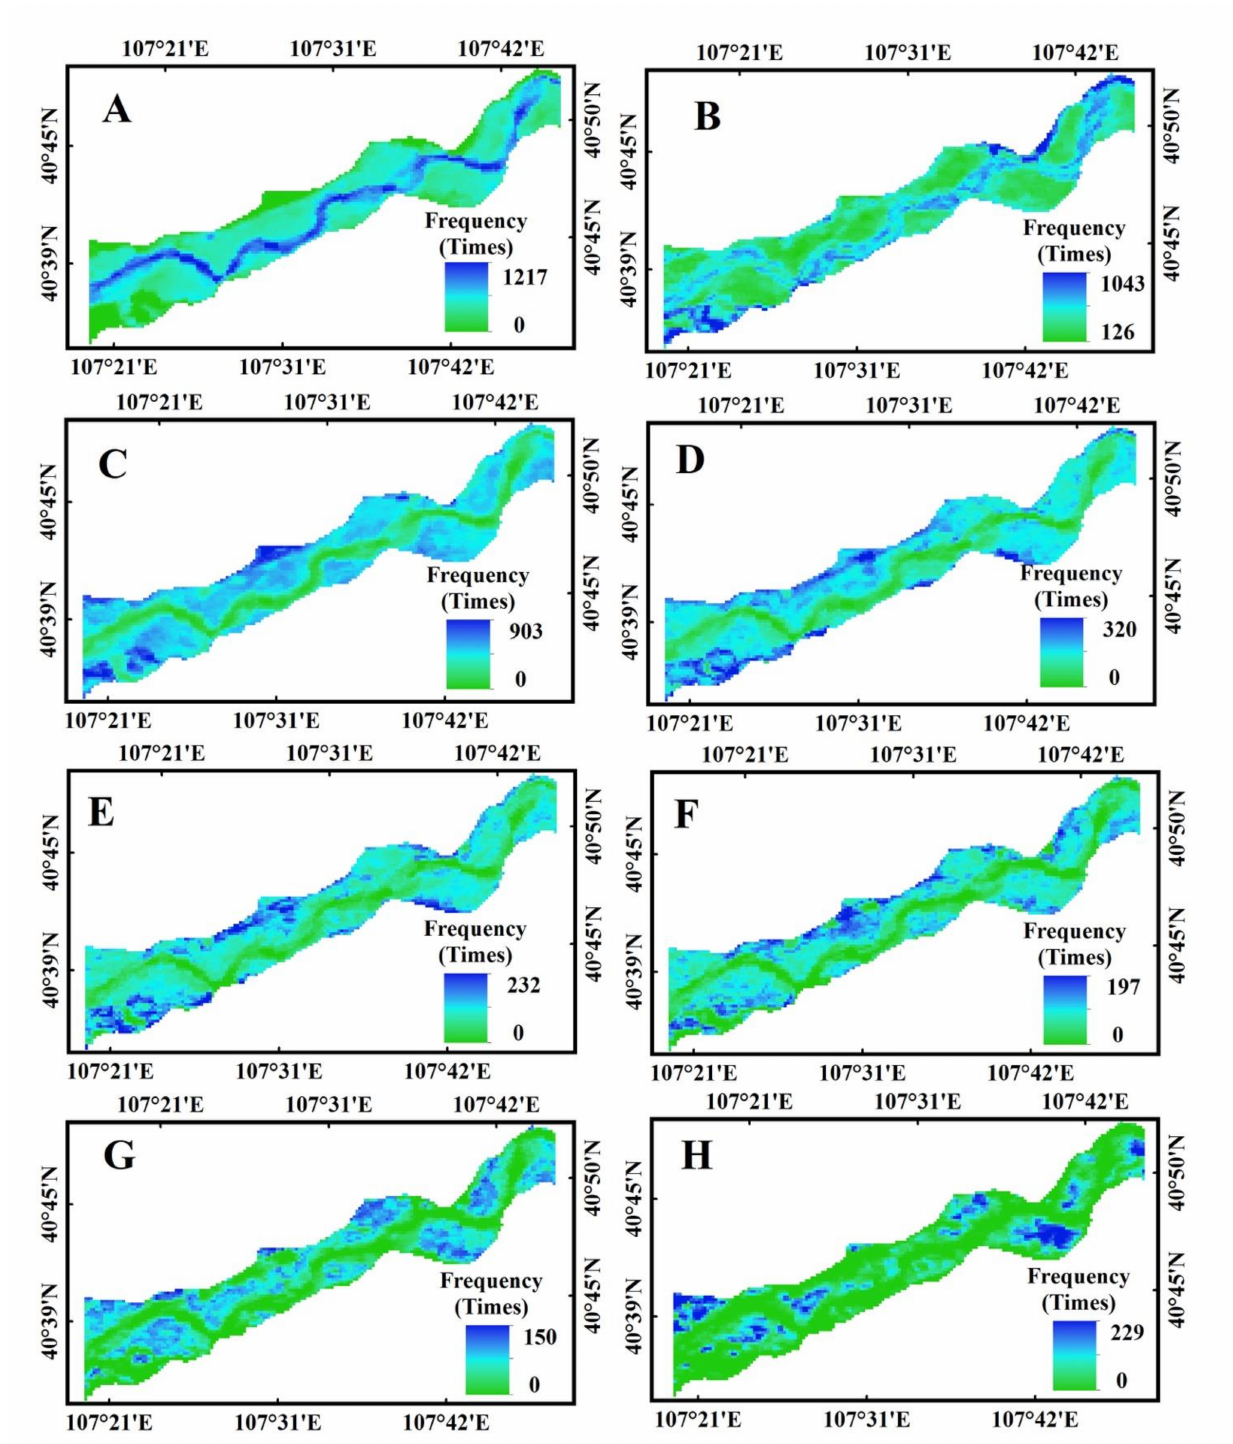
Figure 9. Pixel based spatial distributions patterns of the NDVI frequency. ( A ) Frequencies of value < 0, ( B ) 0–0.09, ( C ) 0.1–0.19, ( D ) <0.2–0.29, ( E ) <0.3–0.39, ( F ) <0.4–0.49, ( G ) <0.5–0.59 and ( H )